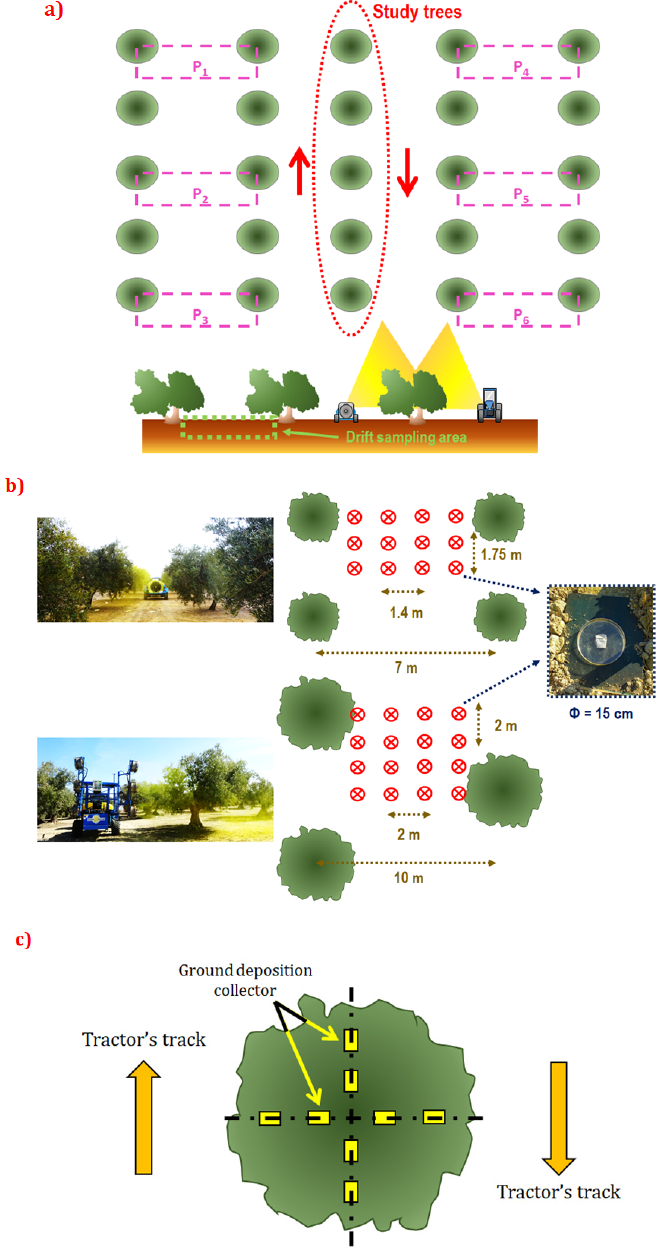
Figure 5. ( a ) Spray drift sampling area placement in relation to the sprayed trees; ( b ) Spray drift sampling grid in a sampling area for the intensive and traditional orchards; ( c ) Sampling of the direct losses to the